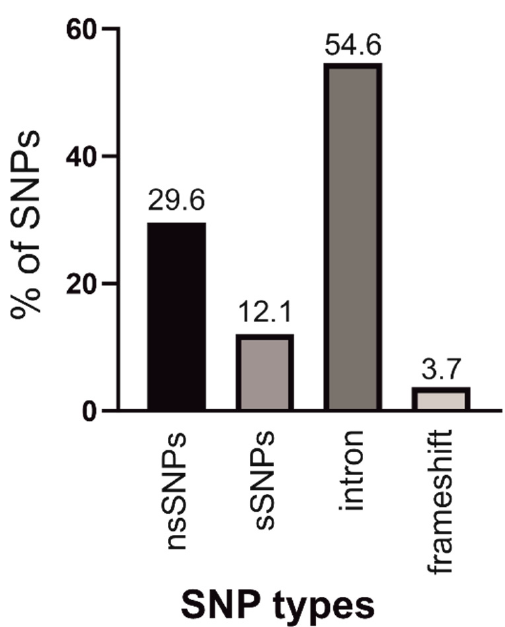
Figure 1. Distribution of coding nsSNPs, coding sSNPs, intronic SNPs, and SNPs causing frameshift in the human ANO4 gene.